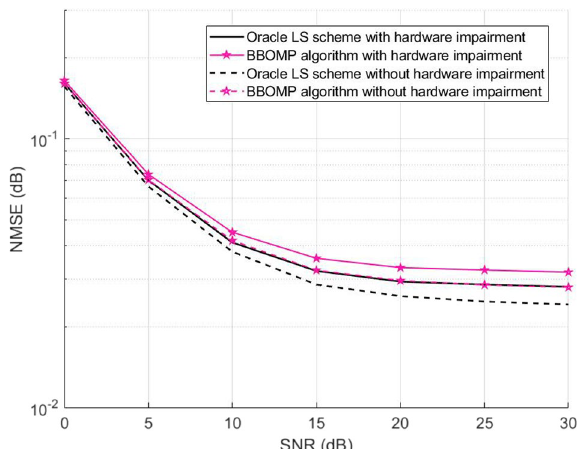
Fig. 11 Effect of hardware impairment on different